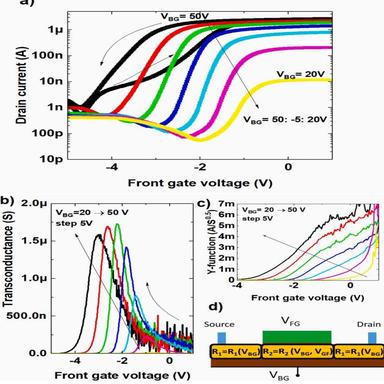
a) Drain current b) transconductance and c) Y-function versus front-gate voltage for various back-gate voltages of the undoped devices with N + poly-Si gate. d) Schematic of the different regions of the device.